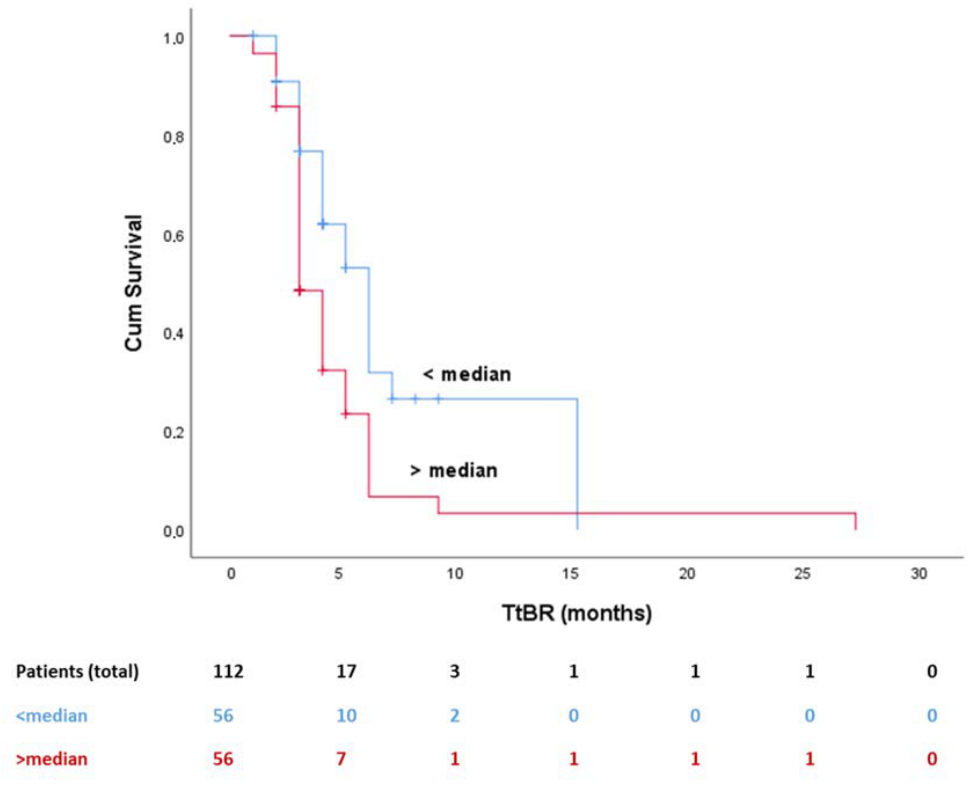
Figure 3. Kaplan–Meier curve for TtBR and PIOS (median value used as cuto ff ). Abbreviations: TtBR, time to best response; PIOS, Patras Immunotherapy